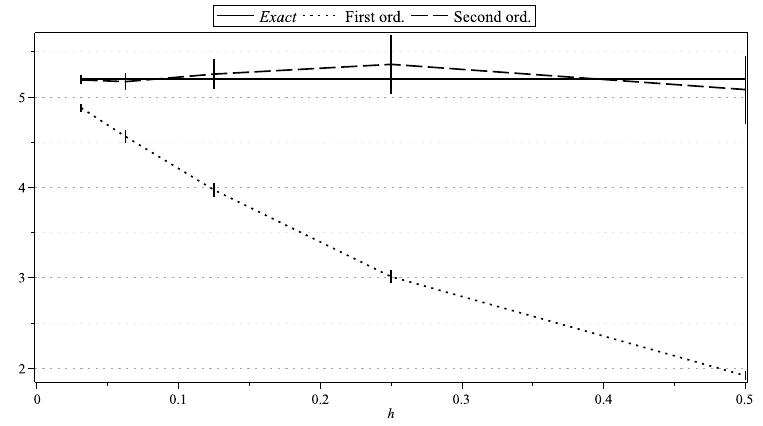
) 3 as functions of h : σ = 0.8, x 1